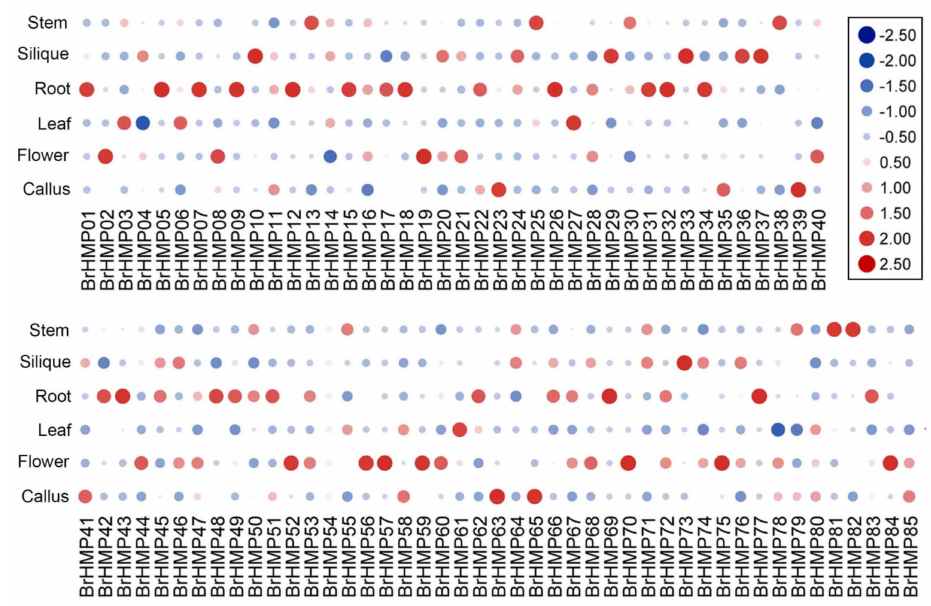
Figure 7. BrHMPs expression in different tissues of B. rapa . The abundance of each gene was measured by